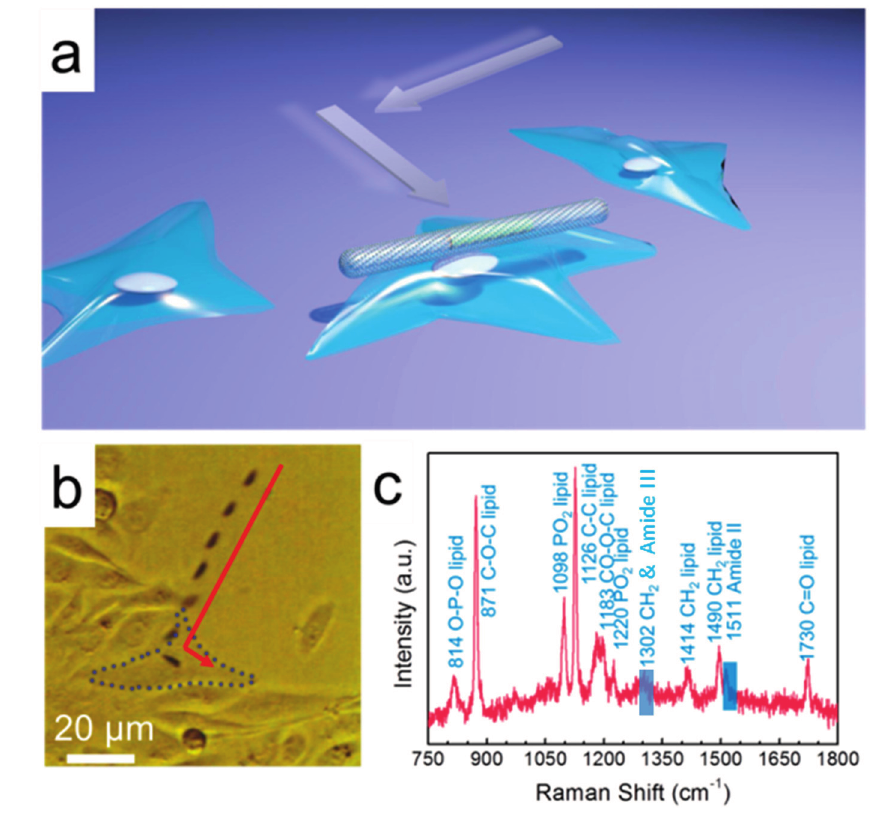
Figure 15. ( a , b ) Transport a partial-hollow nanocapsule motor to a single live Chinese hamster ovary (CHO) cell amidst many; ( c ) SERS spectrum shows the CHO cell membrane is primarily lipid. Two peaks highlighted in blue can be attributed to Amide II and Amide III from proteins (blue bars). With permission from